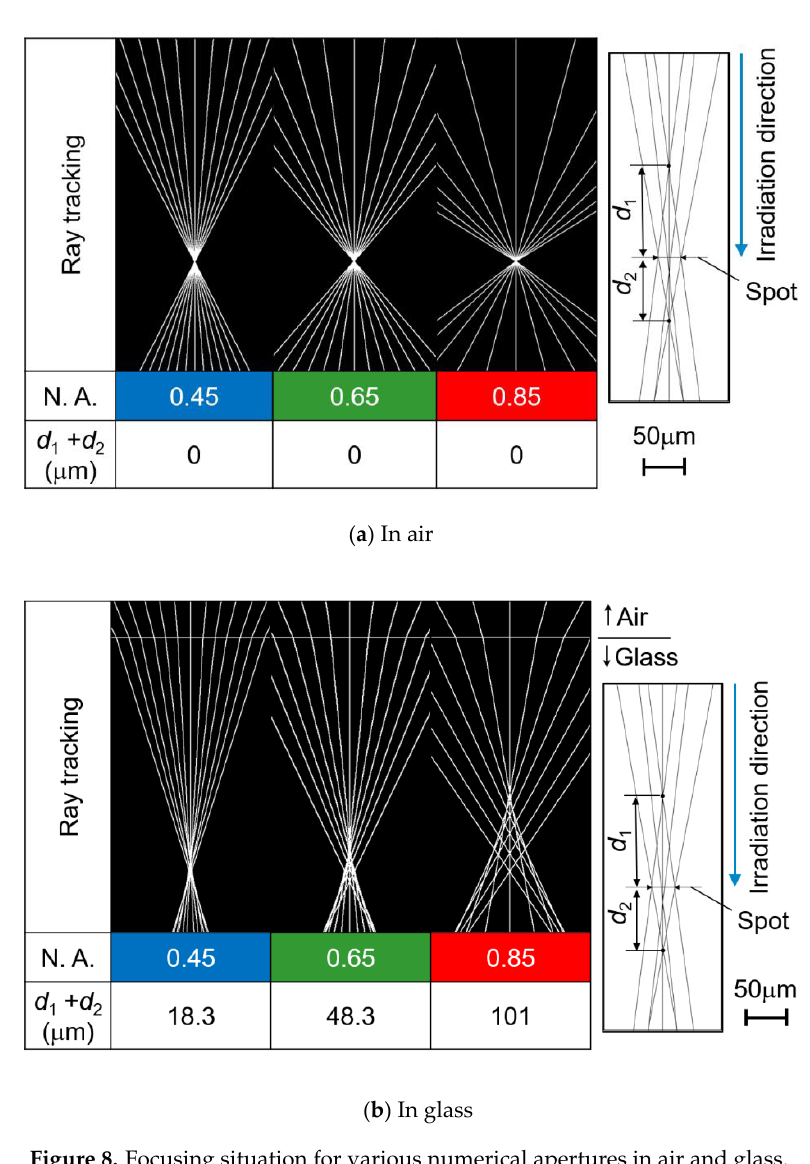
Figure 8. Focusing situation for various numerical apertures in air and glass.